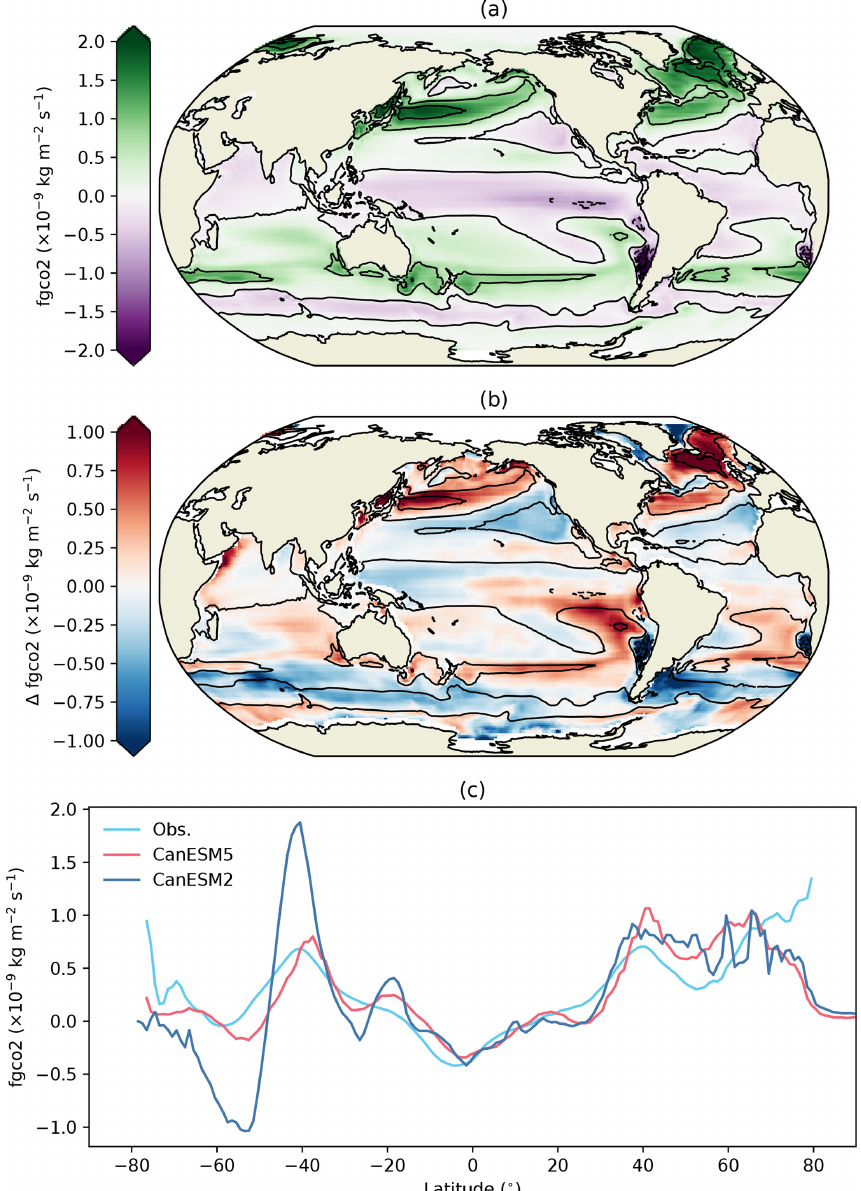
Figure 22. (a) Ocean–atmosphere flux of CO 2 in CanESM5, averaged over 1981 to 2010, (b) the bias relative to Landschützer (2009), and (c) zonal-mean CO 2 flux in CanESM2, CanESM5, and Landschützer (2009) data. The flux is positive downward (into the